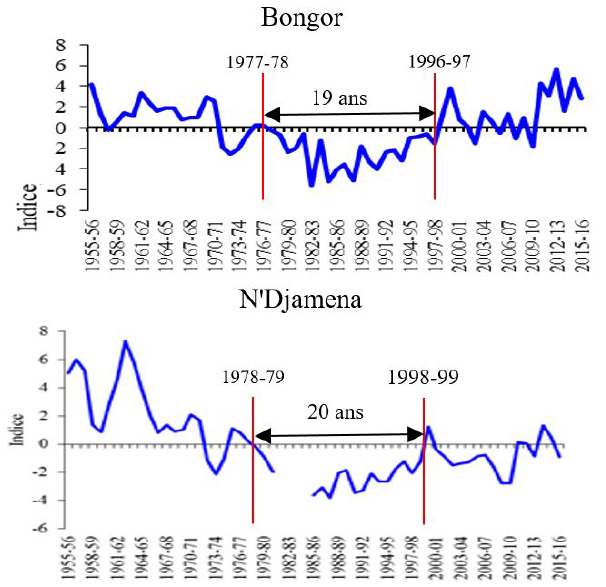
Figure 2. Valeurs de l’indice synthétique de sècheresse hydrolo- gique du Logone à Bongor et du Chari à